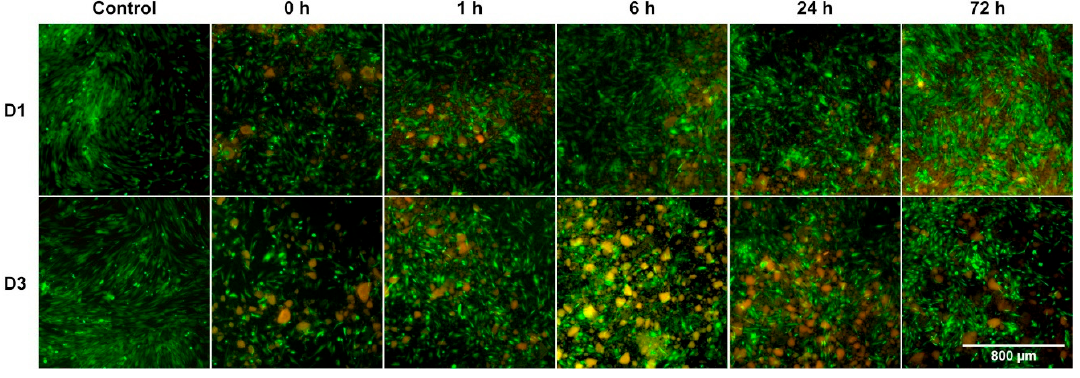
Figure 4. FDA/PI-staining presenting viable cells green-fluorescent and DNA of dead cells red-fluorescent. BG granules appear in orange color. Magnification: 40-fold, reference bar refers to 800 µm.